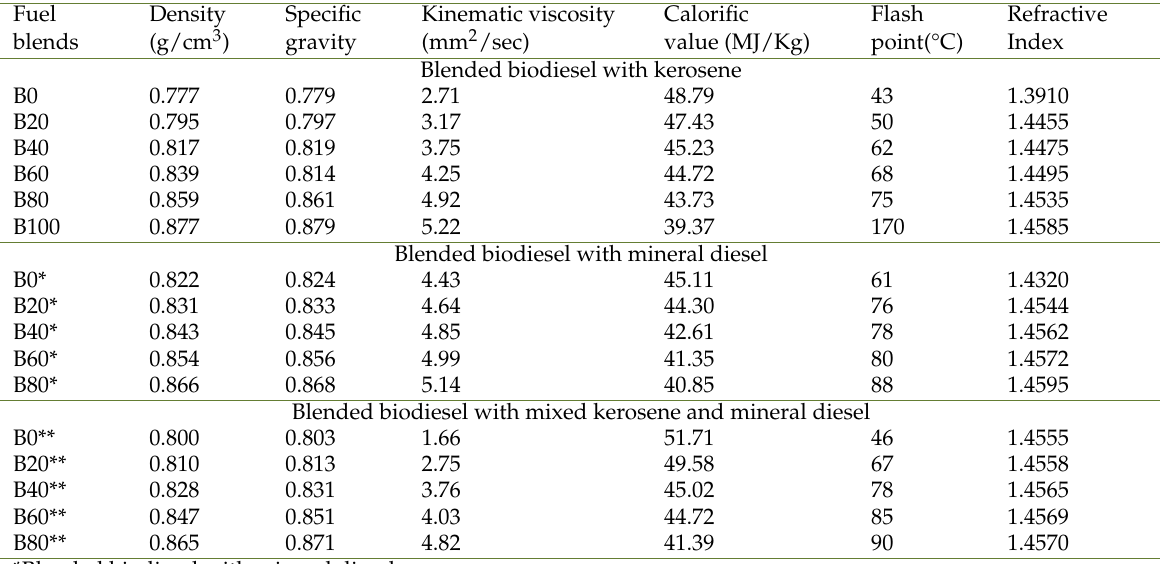
Table 4. Physico-chemical properties of biodiesel blends prepared with kerosene and mineral diesel.